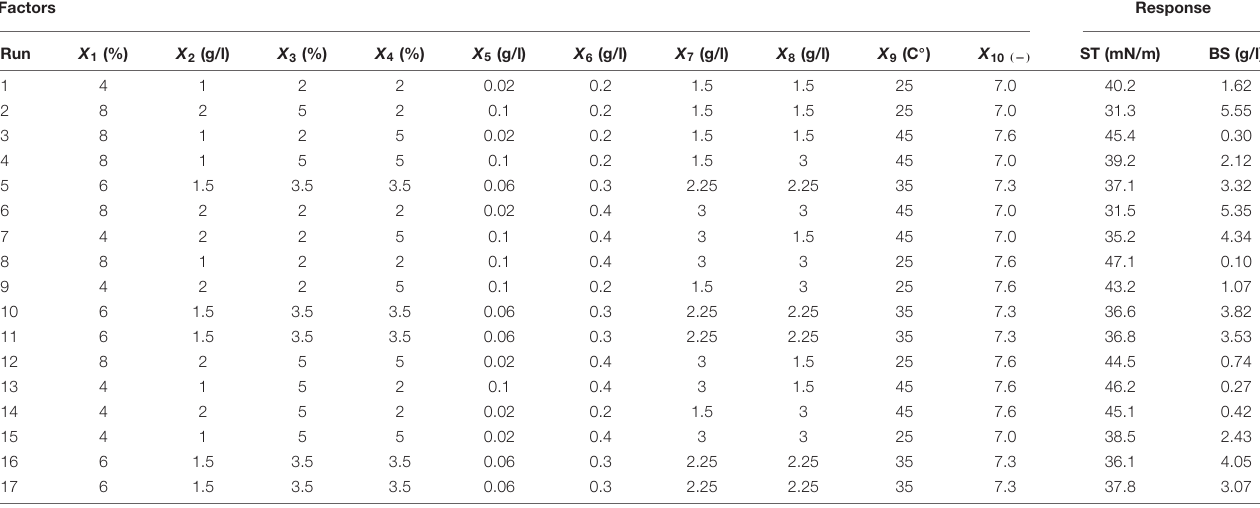
TABLE 1 | The Plackett–Burman experimental design matrix along with results from surface tension (ST) and produced biosurfactant (BS) as the response variables. Factors Response